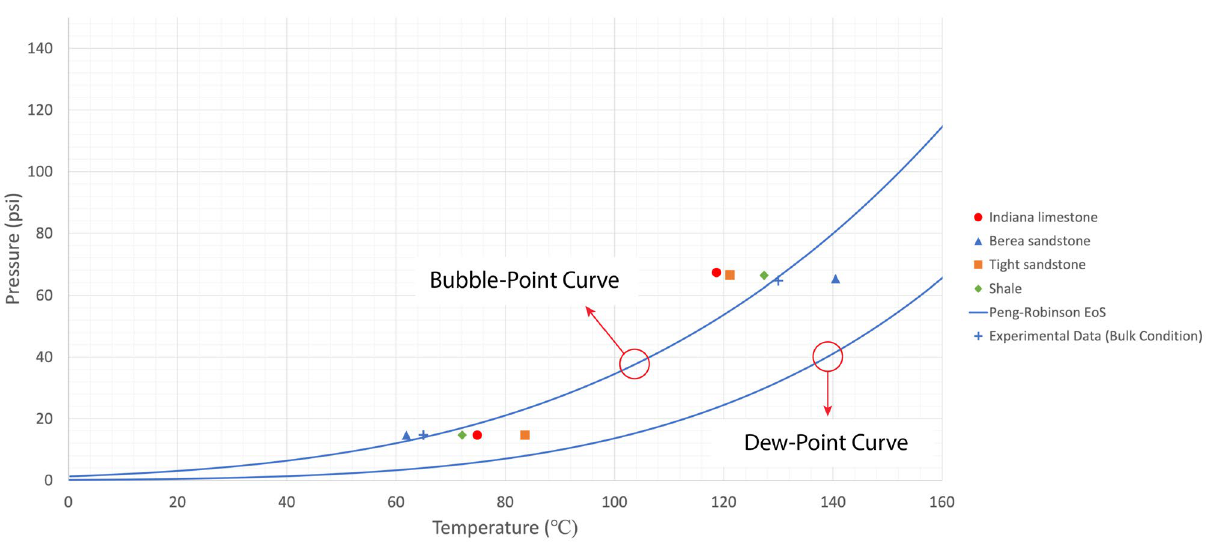
Figure 7. Mean vaporization temperatures of pentane-heptane-octane mixture in various rocks and computed bubble-point/dew-point temperatures obtained from the PR-EoS at different pressures. The experimental data were obtained from the phase-change measurement at bulk